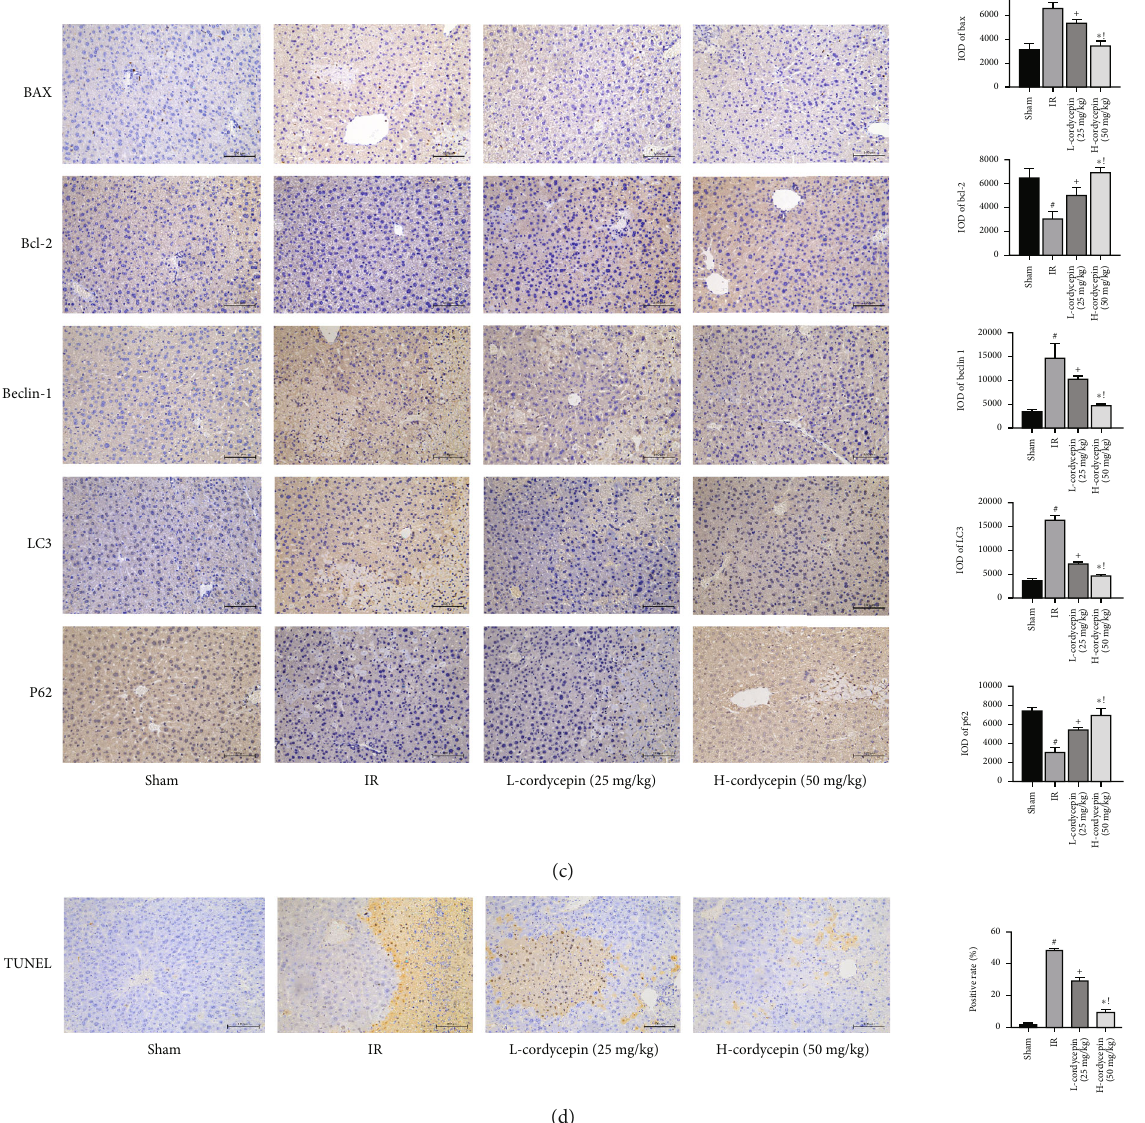
Figure 4: Cordycepin can reduce hepatocyte apoptosis and autophagy induced by HIRI. Note: (a) western blot analysis of Bax, Bcl-2, caspase-3, caspase-9, Beclin-1, LC3, and P62 protein levels. (b) Relative Bax, Bcl-2, Beclin-1, and LC3 levels were determined by qRT-PCR. (c) Bax, Bcl-2, Beclin-1, LC3, and P62 protein expressions in liver tissues after reperfusion are shown by immunohistochemical staining ( × 200). The evaluations were made by the Image-Pro Plus 6.0 software to calculate the IOD of the positive staining area. (d) TUNEL staining showed apoptotic hepatocytes in four groups at 6 h. Final evaluations were made using the ImageJ v1.8.0 software to calculate positive rate. Data are presented as mean ± SD ( n = 6 ; # p < 0 : 05 for IR vs. sham; + p < 0 : 05 for L-cordycepin (25 mg/kg) vs. IR; ∗ p < 0 : 05 for H-cordycepin (50 mg/kg) vs. IR; ! p < 0 : 05 for L-cordycepin (25 mg/kg) vs. H-cordycepin (50